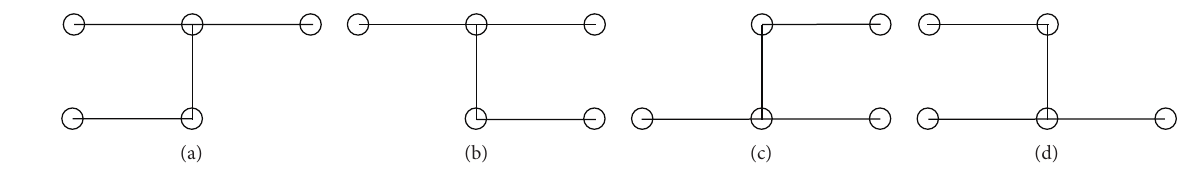
Figure 1: The diagram of Saul’yev asymmetric difference schemes. (a) Scheme (11). (b) Scheme (12). (c) Scheme (13). (d) Scheme